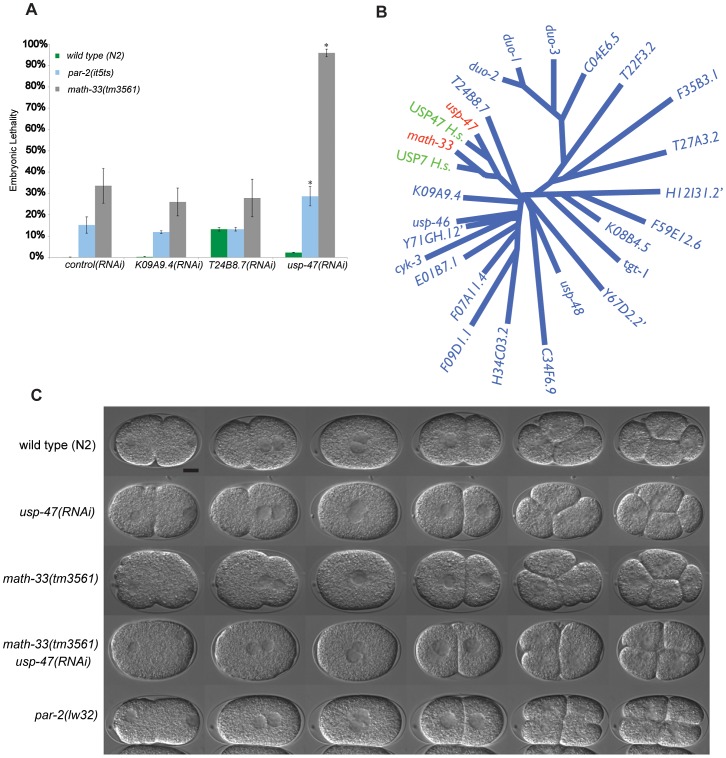
Paralogs math-33 and usp-47 have synthetic polarity phenotypes.(A) Bars indicate percent embryo lethality. >300 embryos were scored for each genotype in two trials. Error bars indicate standard error of the mean; asterisks indicate significant difference compared to controls, p<0.01, determined by Student's t-test. K09A9.4 and T24B8.7 are negative control DUBs. (B) Un-rooted phylogenetic tree of 25 UCH domains in C. elegans and two human homologs of math-33 and usp-47. We did not perform RNAi on the three genes indicated by ‘. Human homologs USP7 and USP47 are included to highlight that there is evolutionary conservation of the DUBs between species. (C) DIC time-lapse of one-cell to four-cell embryos of the indicated genotypes at 22°C. Embryos are oriented with the anterior at the left in this and subsequent figures. The spindle orientation of P1 as it divides is usually longitudinal to the embryo axis, but is transverse in polarity-defective mutants such as par-2(lw32). The scale bar represents 10 µm.